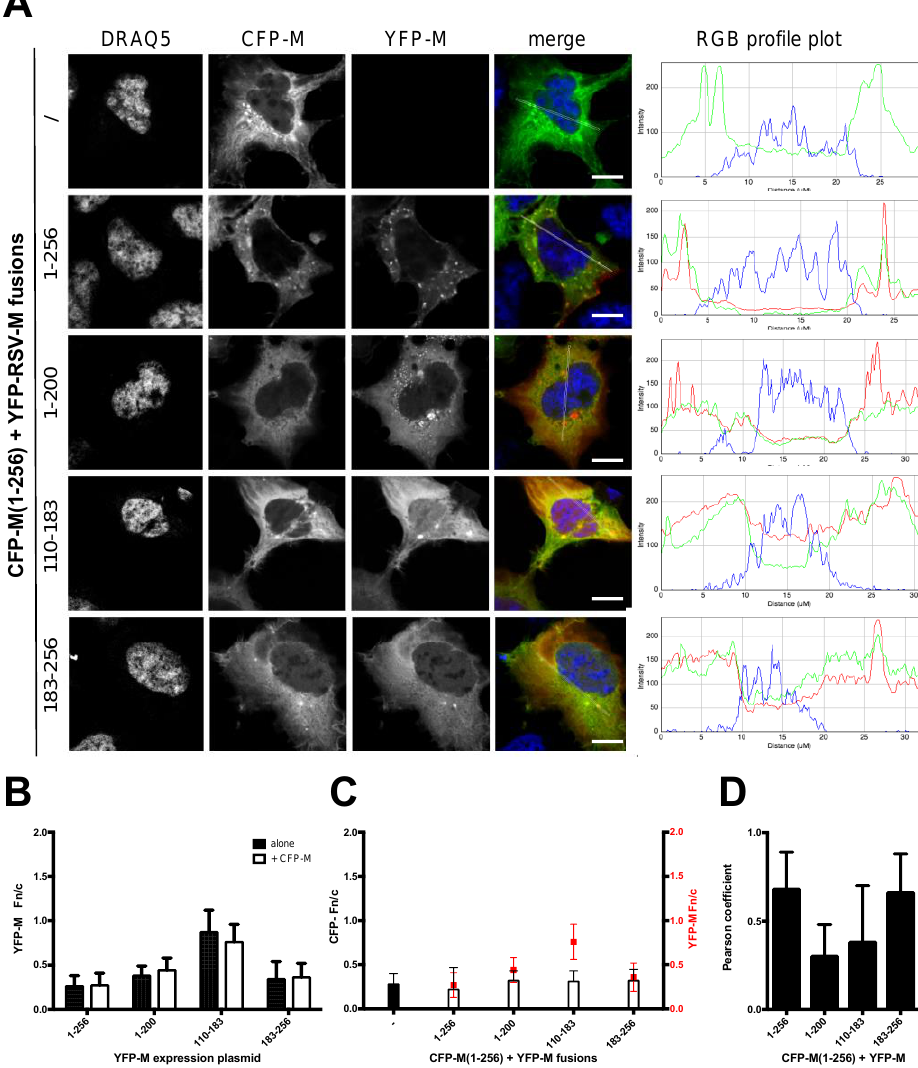
Figure 3. Deletion of N- and C-terminal portions of RSV M affects protein ability to colocalize with full-length protein. ( A ) HEK293 A cells were transfected to transiently express the CFP-M (1–256) fusion protein either in the absence or in the presence of the indicated YFP-M fusions. 24 h post transfection cell nuclei were stained with DRAQ5 and cells processed for CSLM analysis. Representative images relative to cell nuclei (DRAQ5), CFP (CFP-M) and YFP-RSV M fusions (YFP-M) are shown, along with merged images of the three channels (merge). A RGB profile plot relative to the section highlighted in the merge channel is shown on the right panels; ( B ) Digital images such as those shown in ( A ) were quantitatively analyzed using software ImageJ to calculate the Fn/c ratio relative to each of the indicated YFP fusion protein, either expressed alone (black columns) or in the presence of CFP-M (1–256) (white columns). n ≥ 63 from at least two independent experiments; ( C ) Digital images such as those shown in ( A ) were quantitatively analyzed using software ImageJ to calculate the Fn/c ratio relative to CFP-M (1–256), either expressed alone (black columns) or in the presence of (white columns) of each of the indicated YFP fusion protein. Red dots indicate the Fn/c ratio relative to the indicated YFP-M fusions. n ≥ 63 from at least two independent experiments; ( D ) Images such as those shown in ( A ) were used to calculate the Pearson’s coefficient relative to each protein pair. n ≥ 19 from at least two independent experiments. Scale bars represent 20 µ